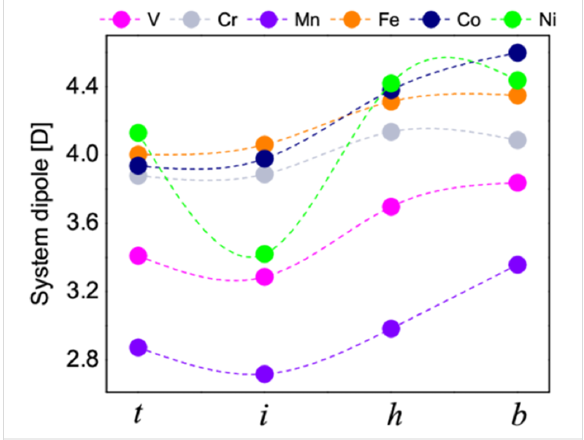
Figure 3: Dipolar moments for all TMPP–metal-surface systems and all relative positions between molecule and